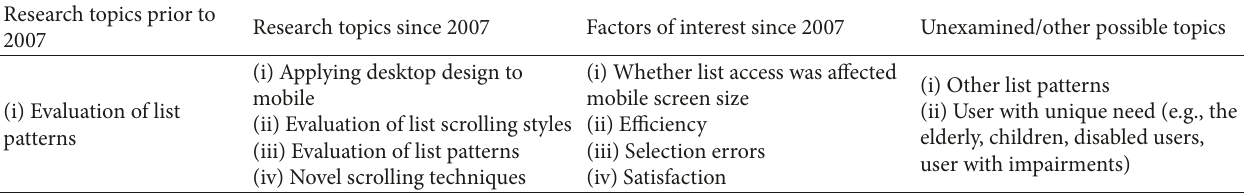
Table 5: Display of information research.